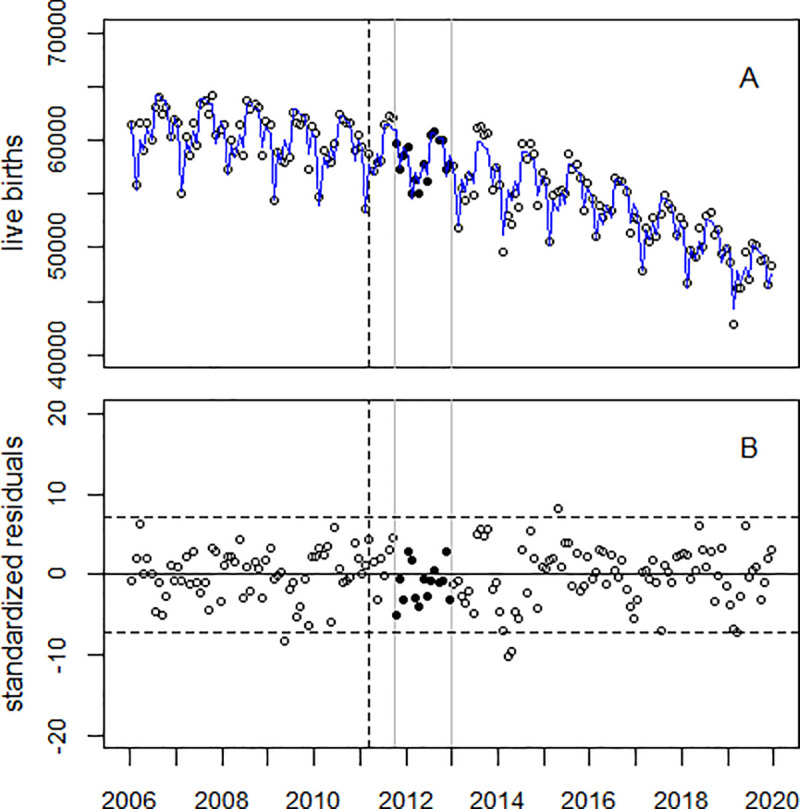
Panel A: Monthly numbers of LB in Japan minus the study region (Area C), 2006–2019, and trend line. Panel B: Standardized residuals. The black circles show the data in the time window (Oct 2011 through Dec 2012); the broken vertical line denotes March 2011.